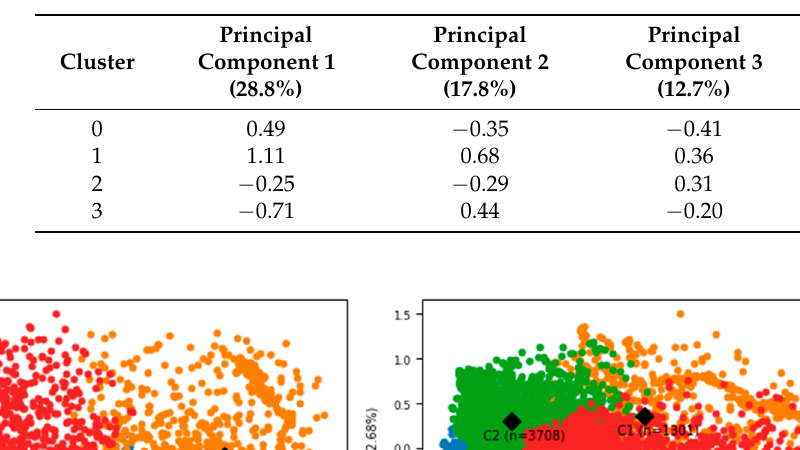
Figure 5. Determining the number of clusters based on the elbow method. Table 7. The four clusters, characterised by the three principal components.